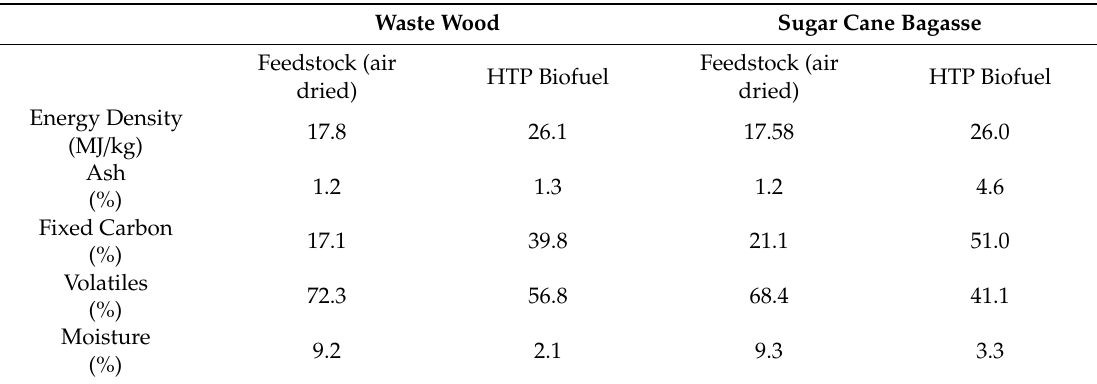
Table 3. TGA/DSC analysis of HTP catalyst biofuel for various feedstocks. Process time was 120 min and the temperature was 230 °C. The catalyst concentration was 2 g/L.